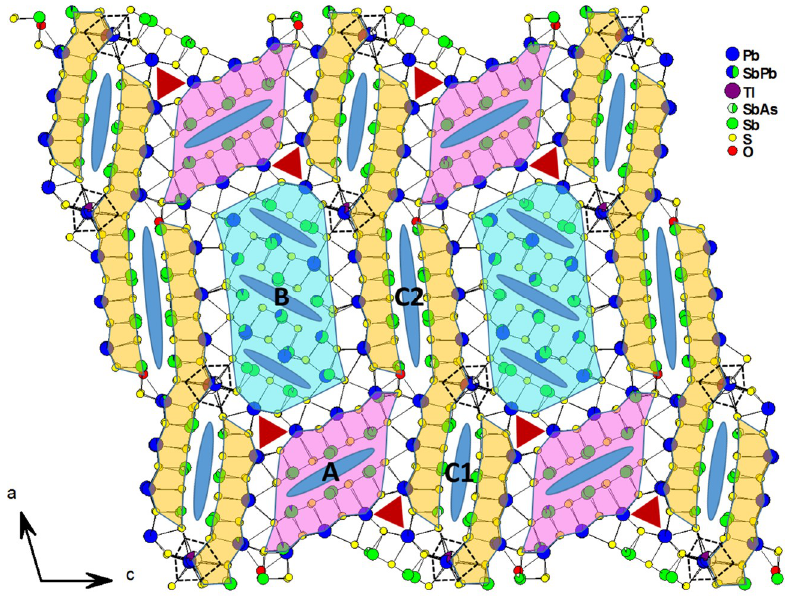
Figure 4. Projection along the b -axis of the crystal structure of Tl-bearing chovanite. The different kinds of modules are shown: A = pink; B = light blue; and C (i.e., C1 + C2) = yellow.